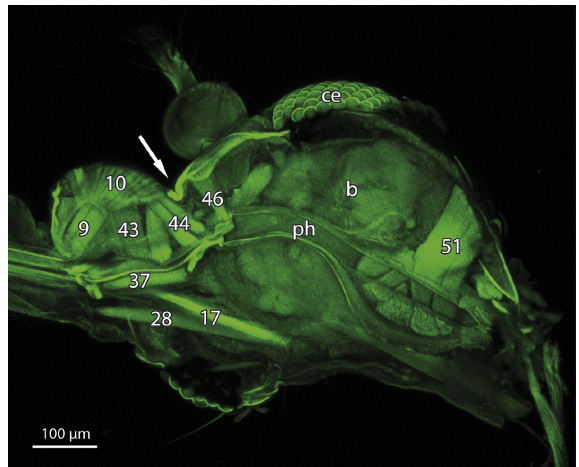
Figure 7 . Culex pipiens (Culicidae), sagital section, CLSM image. Arrow: joint between frons and clypeus. Abbreviations: b, brain; ce, compound eye; ph, pharynx; 9, M. frontoepipharyngalis; 10, M. epistomalabralis; 17, M. tentoriocardinalis; 28, premental retractor; 37, M. hypopharyngosalivarialis; 43, M. clypeopalatalis; 44, M. clapeobuccalis; 46, M. frontobuccalis posterior; 51, M.